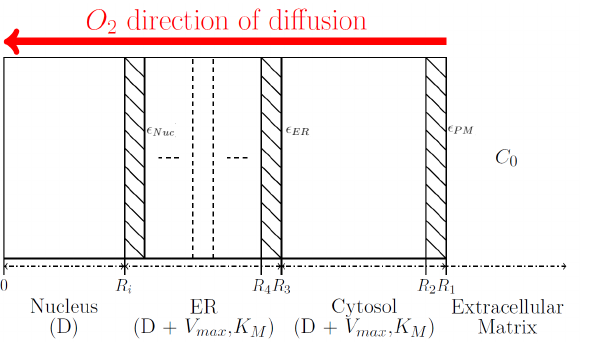
Figure 2. Representation of cellular regions. The cytosol region includes the mitochondria, while the ER includes also the Golgi apparatus. Regions with stripes represents the membrane interface. Note for ER, the number of membranes will be modified during the